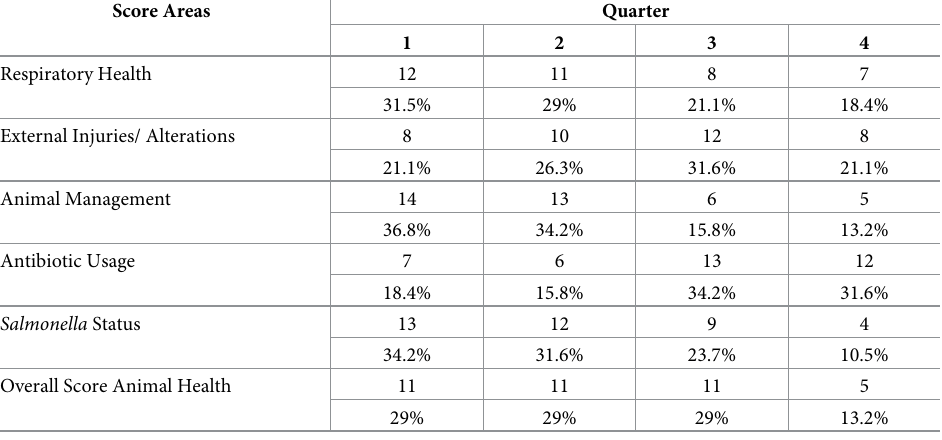
Table 4. Classification of project farm units based on quartile values of the entire collective; all percentage values are rounded values. Score